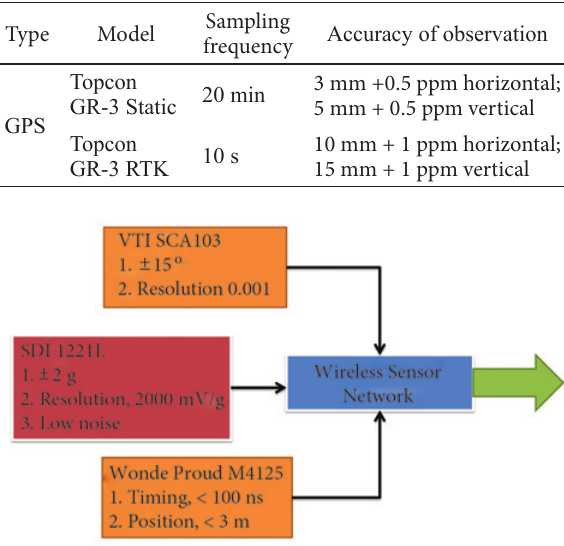
Table 2. The information of GPS equipment